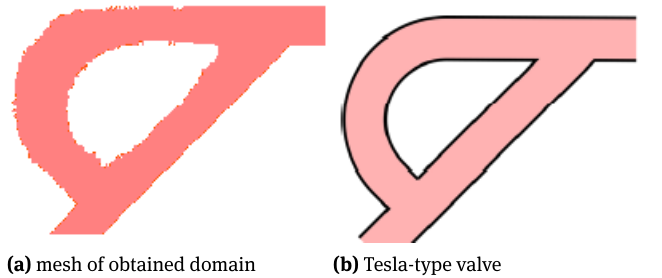
Fig. 5: mesh of obtained design (left) and reference Tesla valve